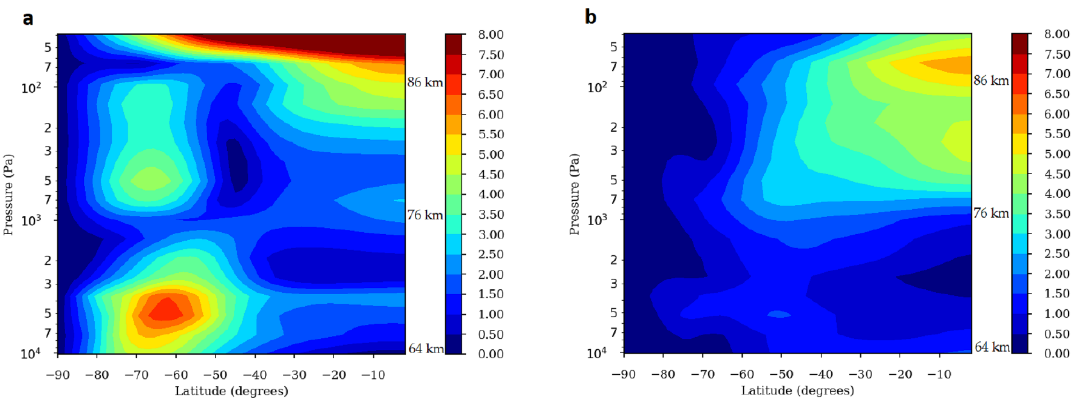
Figure 8. Fast Fourier transform (FFT) components of the temperature in the GCM simulation: ( a ) diurnal component; ( b ) semidiurnal component.